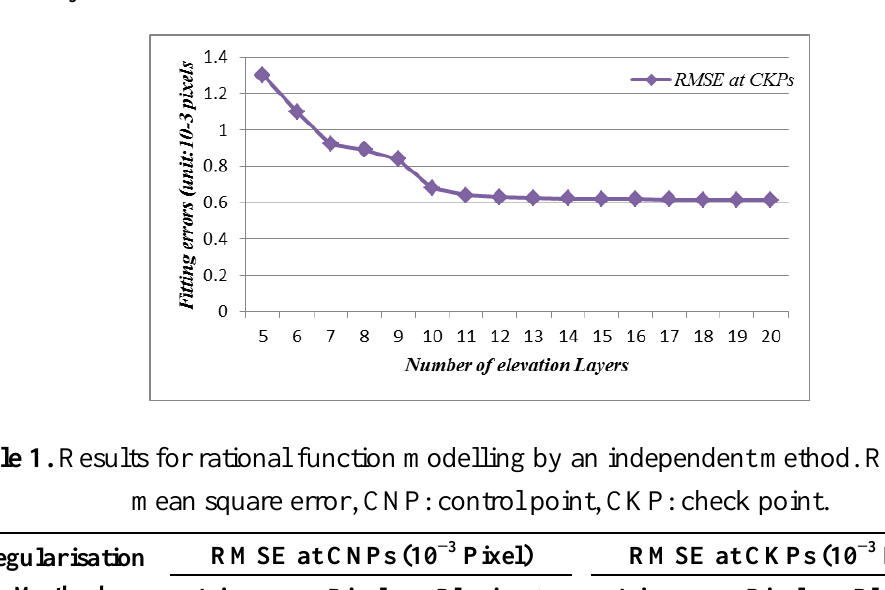
Figure 4. Plot of rational function modell (RFM) fitting errors versus number of elevation layers.